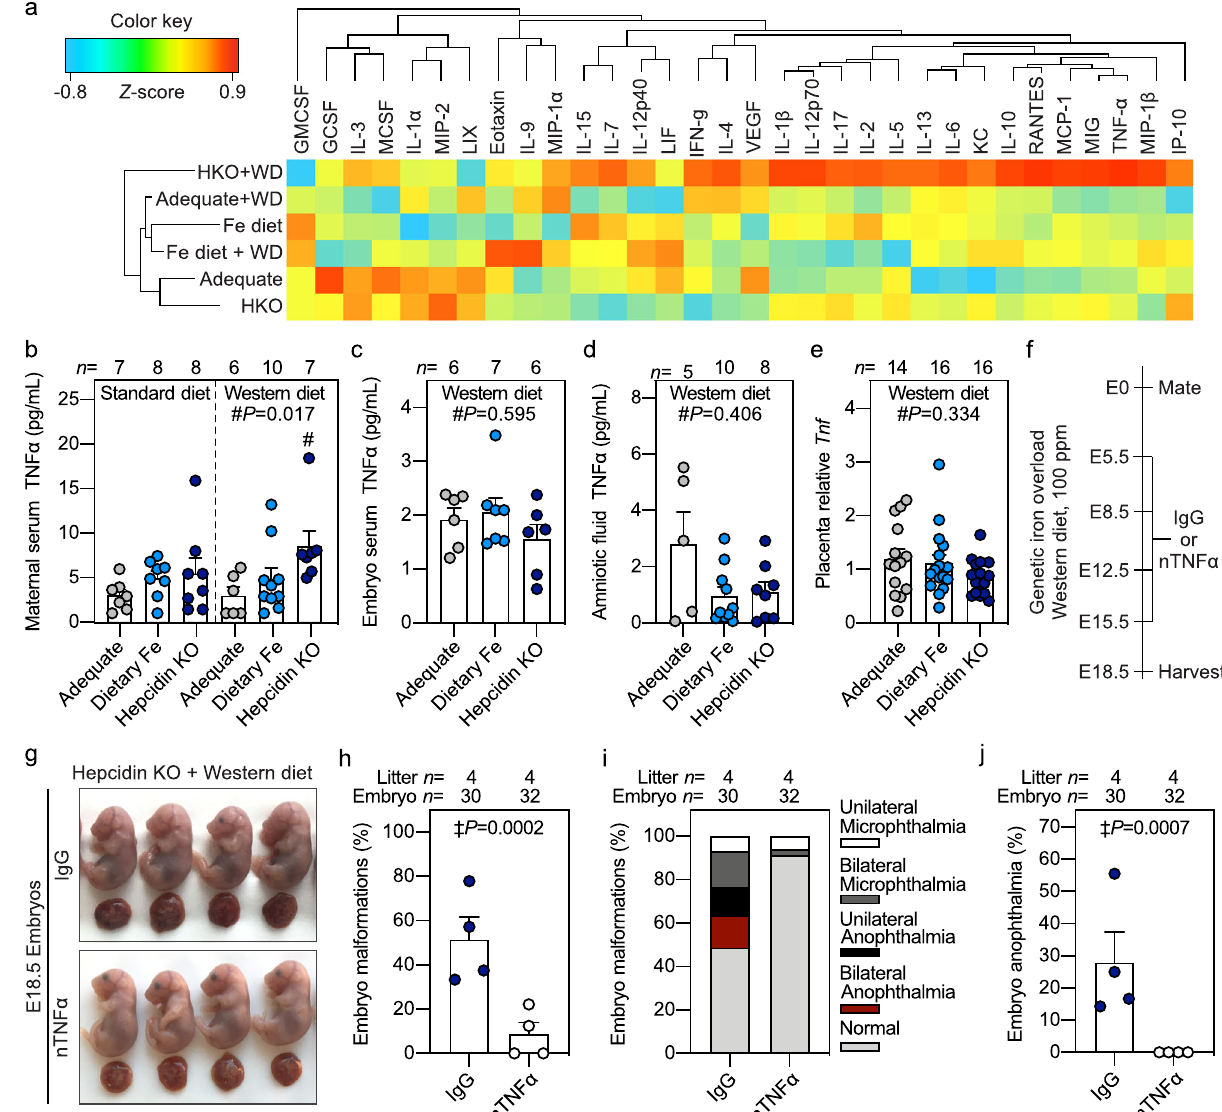
Fig. 7 Neutralizing maternal TNF α is protective against embryonic malformation induced by the combination of high maternal iron and Western diet. a Clustering analysis of 32-plex cytokine panel in maternal serum from iron-adequate (gray circles), dietary iron-loaded (Fe diet, light blue circles), and genetically iron-loaded hepcidin KO (HKO, dark blue circles) dams fed standard or Western diet (WD). Color key indicates Z -score for each cytokine. b – e E18.5 TNF α measurements in b maternal serum, c embryo serum pooled from each litter, d pooled amniotic fl uid, and e placental Tnf gene expression. Placentas were randomly selected for analysis. f Hepcidin KO females were fed Western diet (100 ppm iron) starting at 3 weeks of age and were mated after 9 weeks. Pregnant dams received intravenous injections of neutralizing TNF α antibody (white circles) or isotype IgG (dark blue circles) targeting trinitrophenol as a control (250 µ g/injection) on E5.5, E8.5, E12.5, and E15.5, and embryo outcome was evaluated at E18.5. g Embryo gross morphology. h – j Incidence of eye malformations. b – e , h , j Error bars represent mean ± s.e.m. Statistical differences were determined by one-way ANOVA on ranks followed by Dunn ’ s method for multiple comparisons (denoted by #) or two-tailed Fisher ’ s exact test (indicated by ‡ ). P -values are indicated in each fi gure panel. Source data are provided as a Source data fi